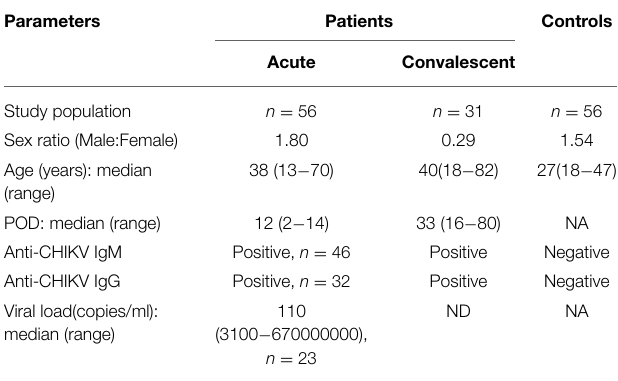
TABLE 1 | Characteristics of study population.